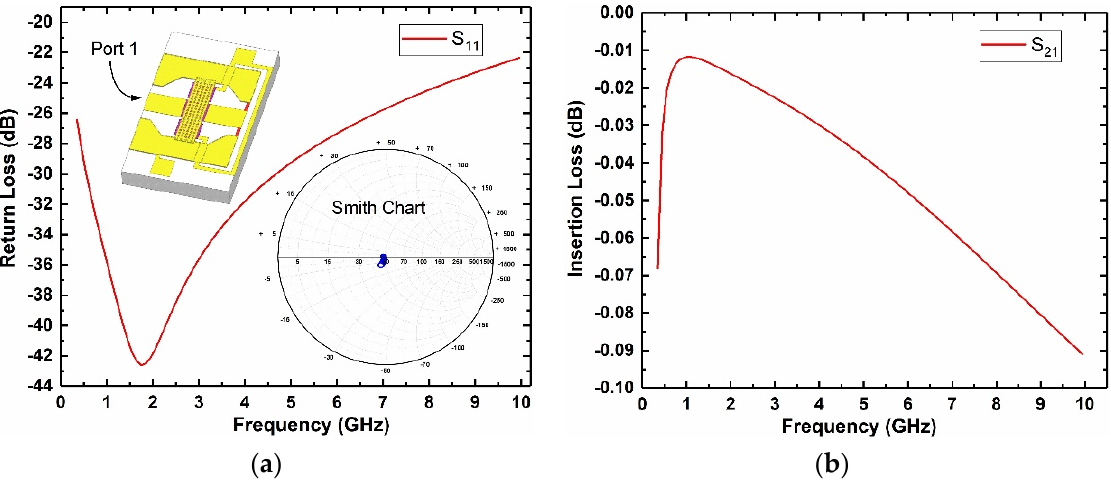
Figure 4. Microwave performance: ( a ) MEMS demodulator return losses S 11 ; ( b ) capacitive transducer insertion loss S 21.